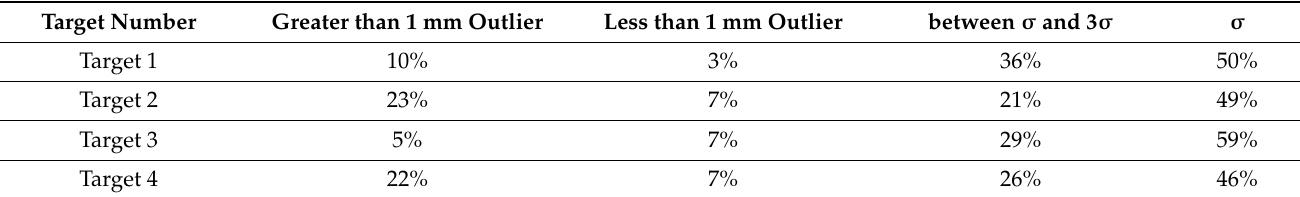
Table 1. Percentage breakdown of the outliers and true values based on 0.08 mm sigma and 3.21 mm mean value. Target Number